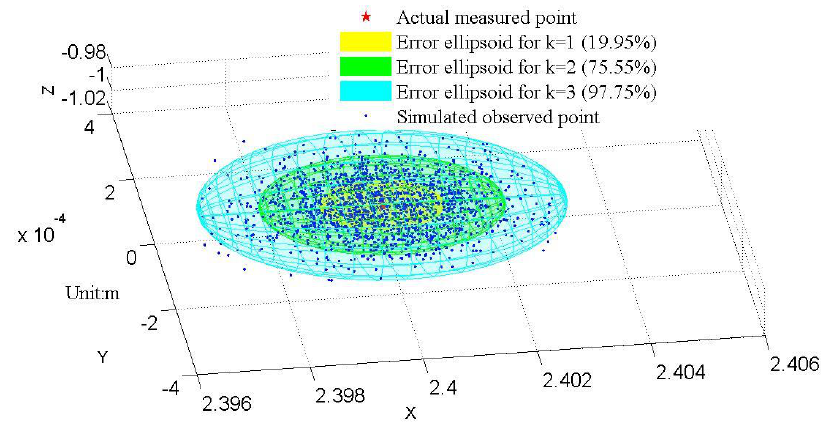
ř ´ 1 r “ k 2 x , y , z